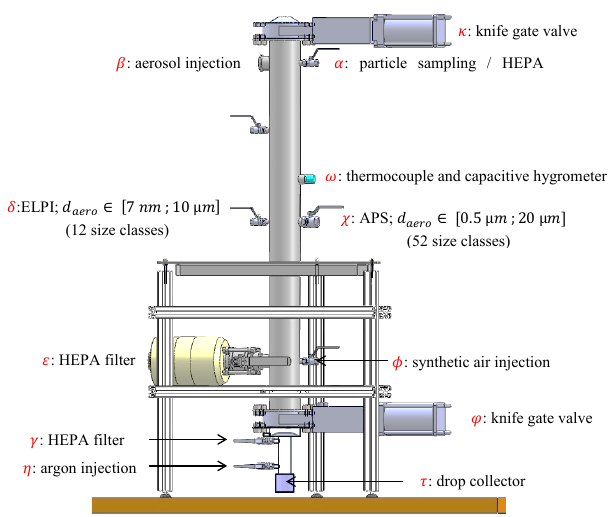
Figure 7. Schematic design of the new BERGAME aerosol cham-